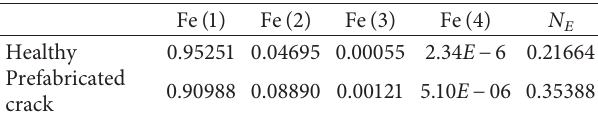
Table 3: Damage detection index value of pillar porcelain insulator under hammer